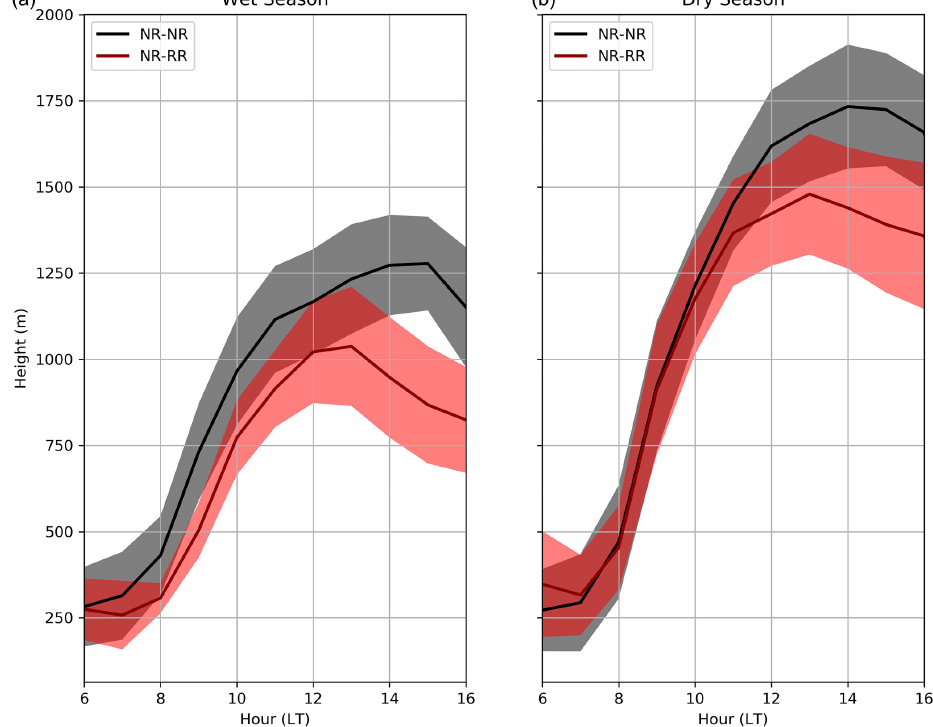
Figure 8. Planetary boundary layer mean (composite dataset) height derived with the ceilometer for dry and wet seasons and NR–NR and NR–RR transitions. Shaded areas represent 1 standard deviation.